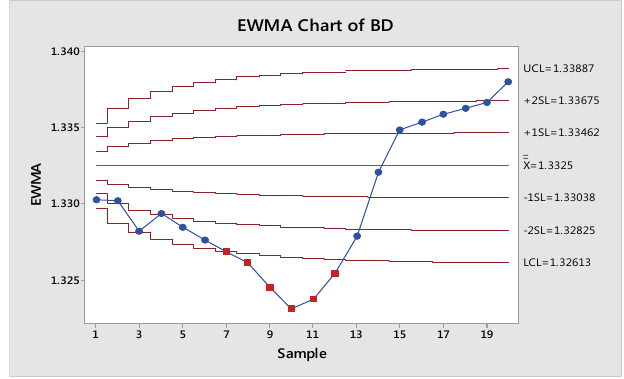
Fig. 1. EWMA Chart